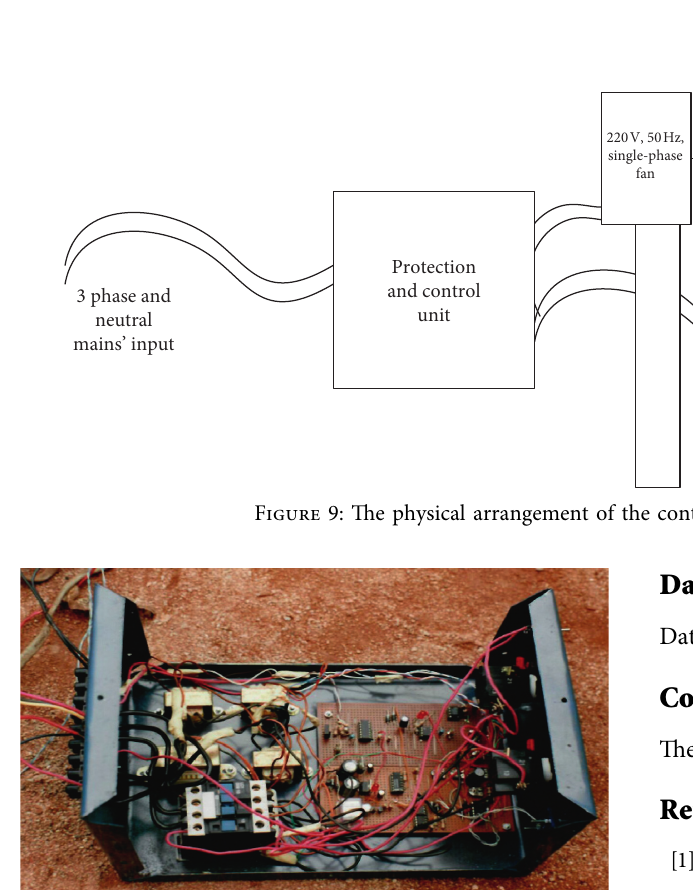
Figure 10: The assembled system.